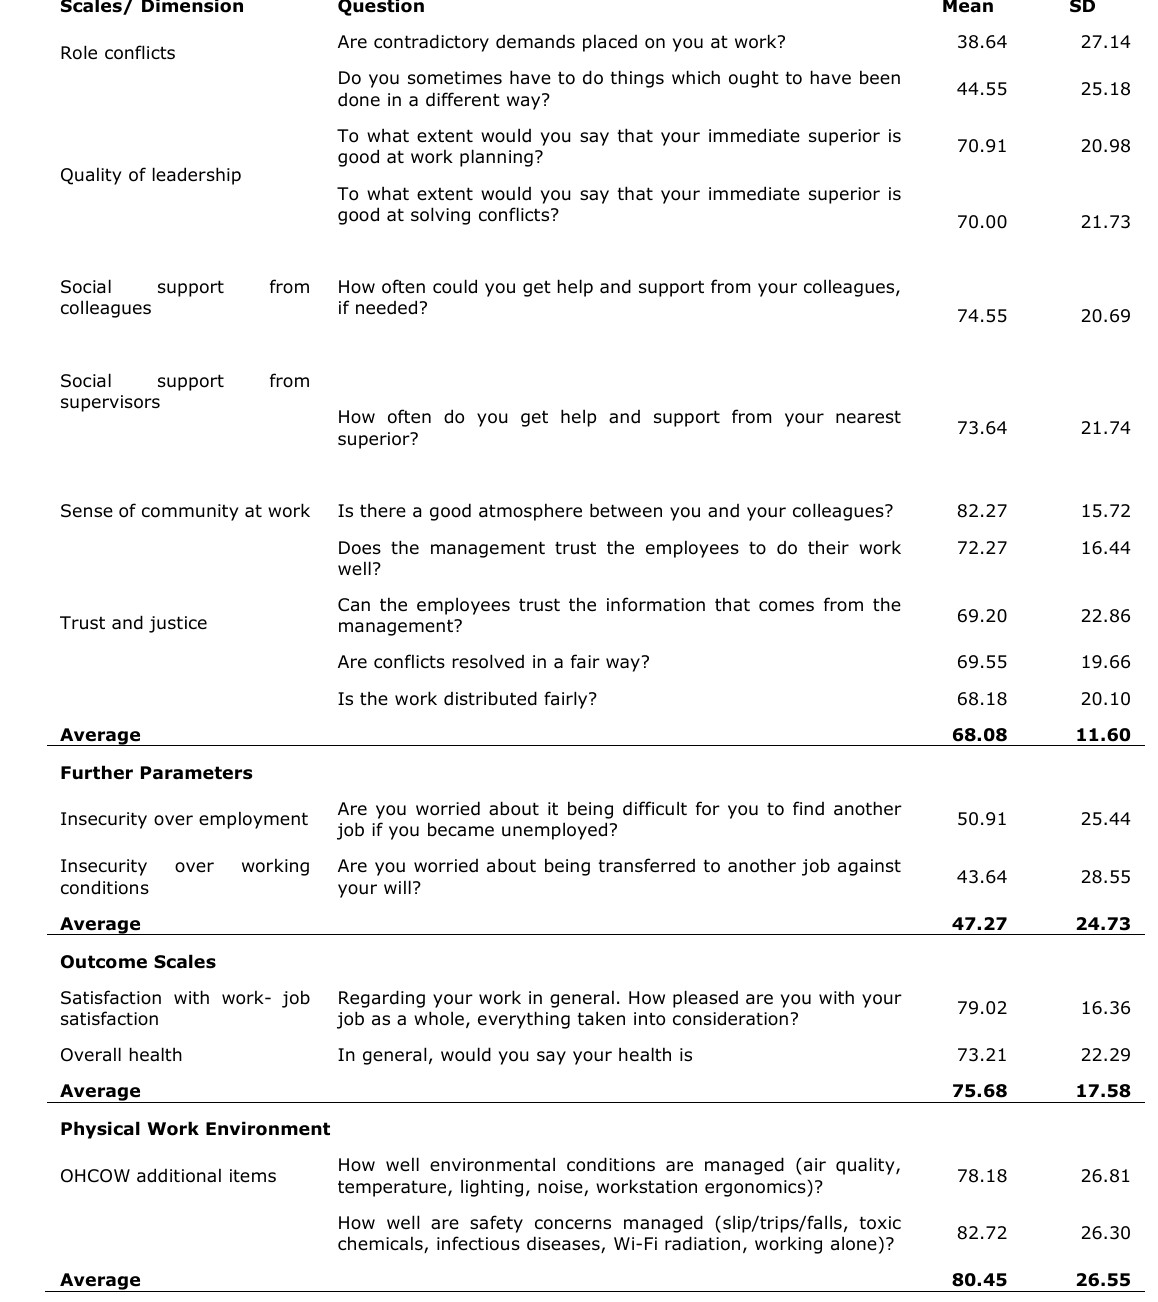
Table 4 presented the interpretation key used to classify the average level of agreement for each statement derived from COPSOQ III to determine PH. A mean score obtained for every question for each of the five dimensions was compared to a rating scale to come up with a verbal